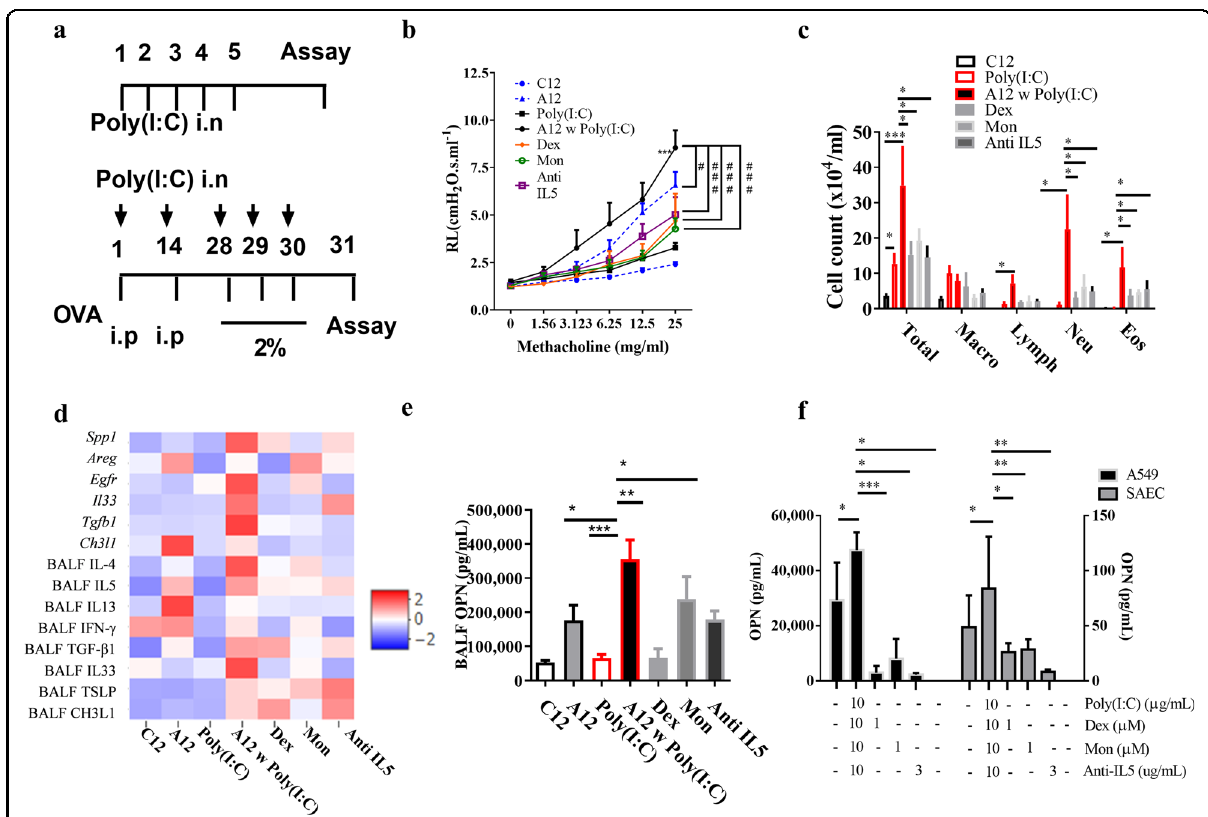
Fig. 3 Virus-induced asthma exacerbation in older mice. a Intranasal poly(I:C) 10 μ g was administered to mice either for 5 days or prior to OVA sensitization/challenge as in the described protocol. b AHR to methacholine was measured on the indicated days. Some mice were treated with dexamethasone (Dex) 1 mg/kg, montelukast (Mon) 10 mg/kg, or anti-IL5 antibody (20 μ g per mouse) for 3 days prior to OVA challenge. *** P < 0.001 vs. the control, # P < 0.05, ### P < 0.001 between the A12 w Poly(I:C) group and drug-treated mice. c Effects of virus and drugs on total cell, neutrophil, and eosinophil counts in BALF. * P < 0.05, *** P < 0.001 between the groups; NS not signi fi cant. d Relative changes in gene expression and levels of proin fl ammatory cytokines in BALF. e The levels of OPN in BALF increased with viral exposure and decreased with anti-asthmatic drugs. * P < 0.05, ** P < 0.01, *** P < 0.001 between the indicated groups. In an in vitro experiment, HAECs were stimulated with poly(I:C) at 1 and 10 μ g/mL and treated with Dex, Mon, and anti-IL5 antibody at the indicated concentrations. f Levels of OPN in the cell culture supernatants were measured by ELISA. * P < 0.05, ** P < 0.01, *** P < 0.001 between the groups. AHR airway hyperresponsiveness; Alum aluminum hydroxide; Areg amphiregulin; BALF bronchoalveolar lavage fl uid; CH3L1 chitinase 3-like 1; Dex dexamethasone; Egfr epidermal growth factor receptor; Eos eosinophil; IFN- γ interferon γ ; IL interleukin; Lymph lymphocyte; Macro macrophage; Mon montelukast; Neu neutrophil; OPN osteopontin; poly(I:C) polyinosinic:polycytidylic acid; Spp1 secreted phosphoprotein 1; Total total cell count; TGF- β 1 transforming growth factor β 1; TSLP thymic stromal